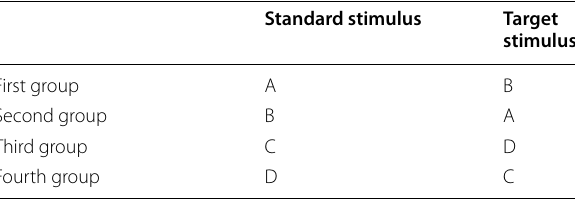
Table 1 Standard stimulus and target stimulus in each group Standard